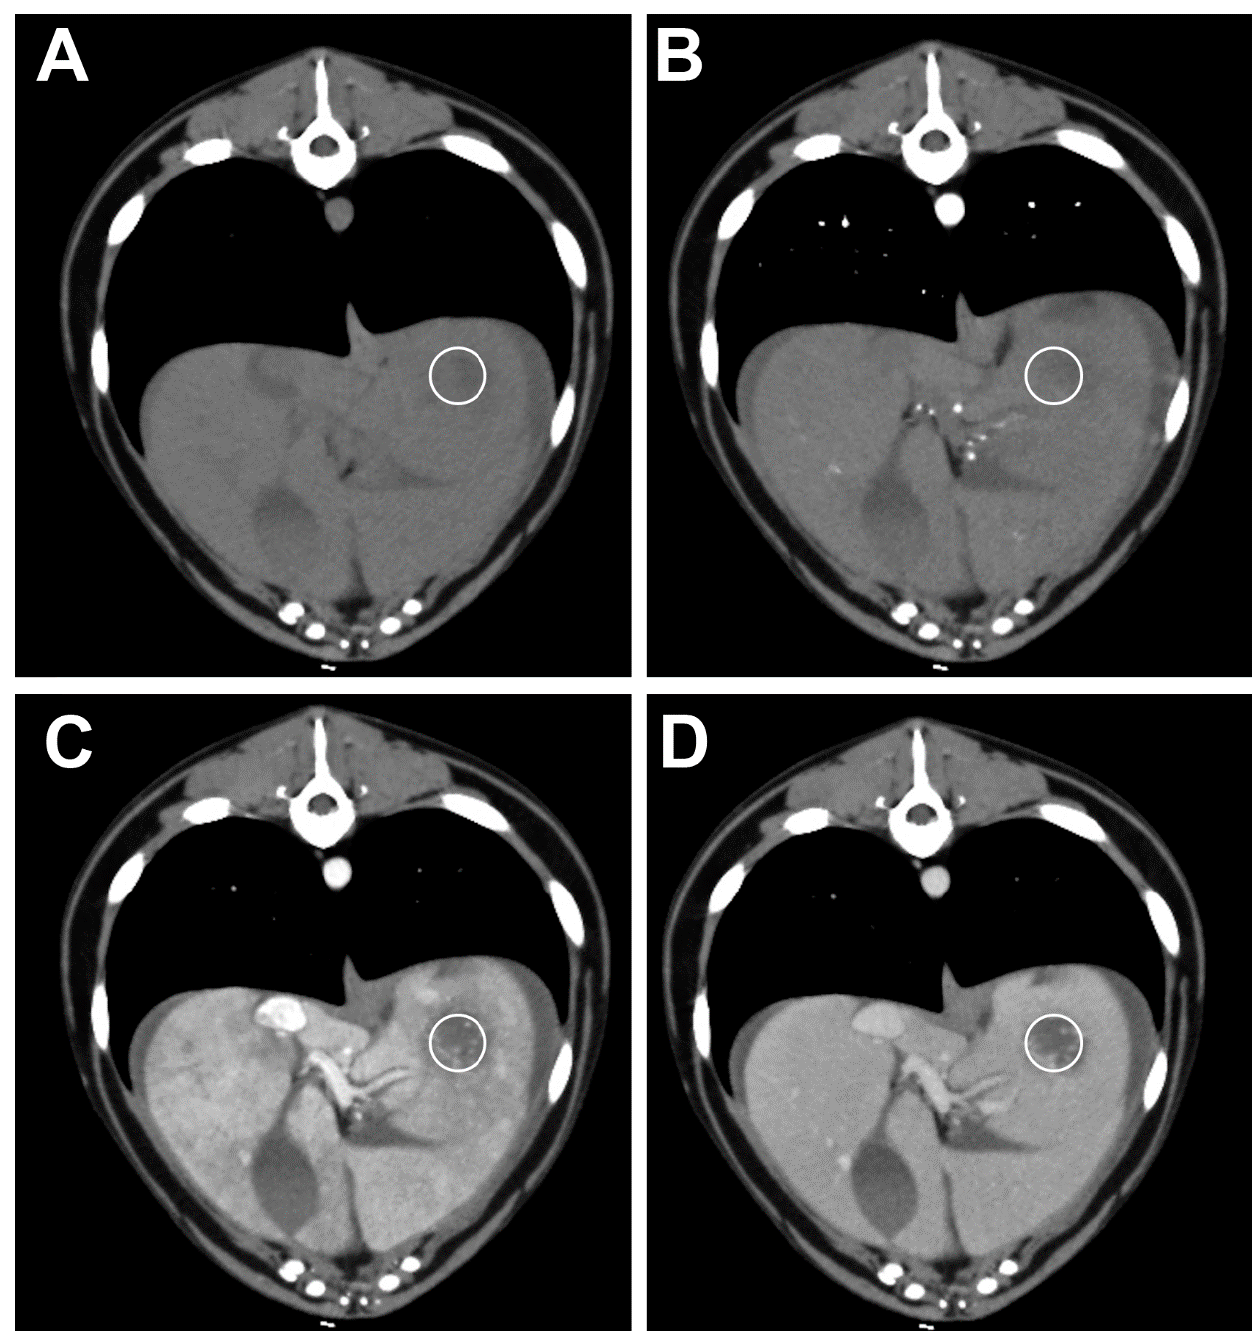
Figure 4. Transverse plane images of a TP-MDCT in a dog with hepatic inflammation. The pre-contrast ( A ) and arterial ( B ) phase images are of an isoattenuating lesion in the left hepatic division. In the portal ( C ) and delayed ( D ) phase images, the lesion is hypoattenuating with multiple tiny contrast-enhancing spots. The white circle shows the location of the ROI used for the measurement.